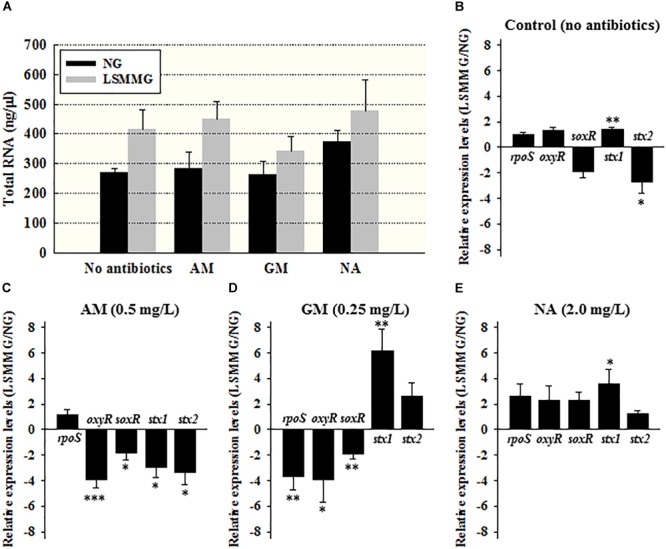
(A) Total RNA concentrations (ng/μl), and the average relative expression of the stress or virulence-related genes in E. coli ATCC 43895 cells cultured under NG and LSMMG in (B) MH broth (no antibiotics) and in the presence of 1/2 × MIC of (C) AM, (D) GM, and (E) NA for 24 h. The data are presented as the mean ± standard error (SE) from six independent experiments. The asterisks represent significant differences between NG and LSMMG cultures (∗P < 0.05, ∗∗P < 0.01, and ∗∗∗P < 0.001).